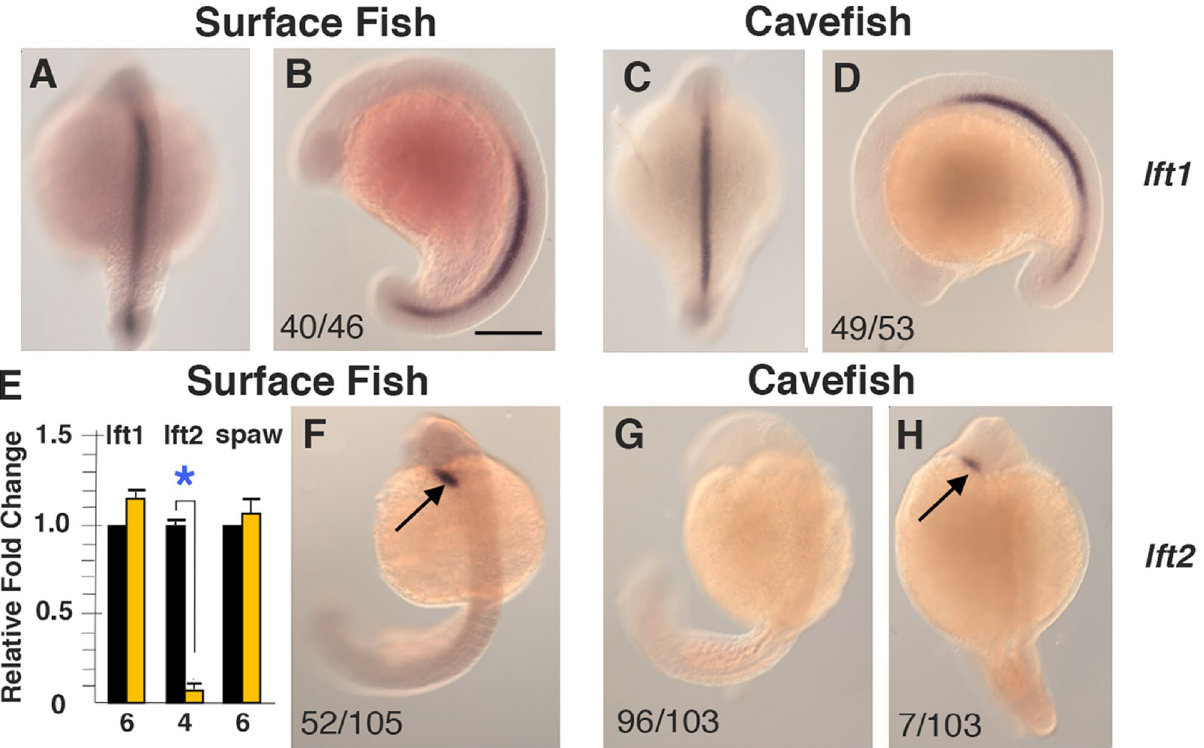
Figure 4. The expression of lefty genes in surface fish and cavefish embryos during segmentation. ( A – D ) In situ hybridization showing lft1 expression along the dorsal midline in 10–13 somite surface fish ( A , B ) and cavefish ( C , D ) embryos. ( A , C ) Dorsal views with anterior on the top. ( B , D ) Lateral views with anterior on the left. ( F – H ) In situ hybridization showing lft2 expression in the LPM (arrows) in 18–25 somite surface fish ( F ) and cavefish embryos ( G , H). Dorsal views. The numbers in the frames indicate embryos with the indicated expression pattern compared to the total number of in situ hybridized embryos. Scale bar in ( B ): 100 µm; magnification is the same ( A – D ) and ( F – H ). ( E ) Bar graph showing relative fold changes in lft1 , lft2 , and spaw mRNA levels in cavefish compared to surface fish determined by qPCR at the 18–25 somite stage. Black bars: surface fish. Yellow bars: cavefish. Error bars: SEM. Number of replicates shown at the bottom of the columns. Asterisk: p <